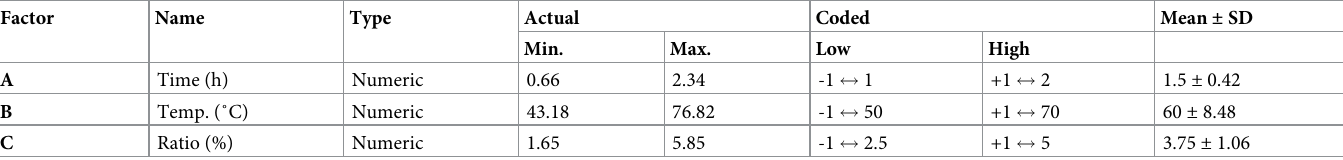
Table 1. Coded and original values for independent variables used in the CCRD for